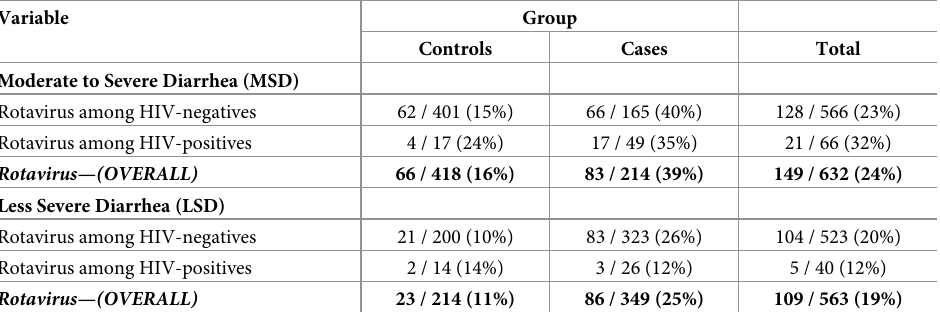
Table 6. Distribution of rotavirus infection in children with MSD and LSD according to HIV status cases and